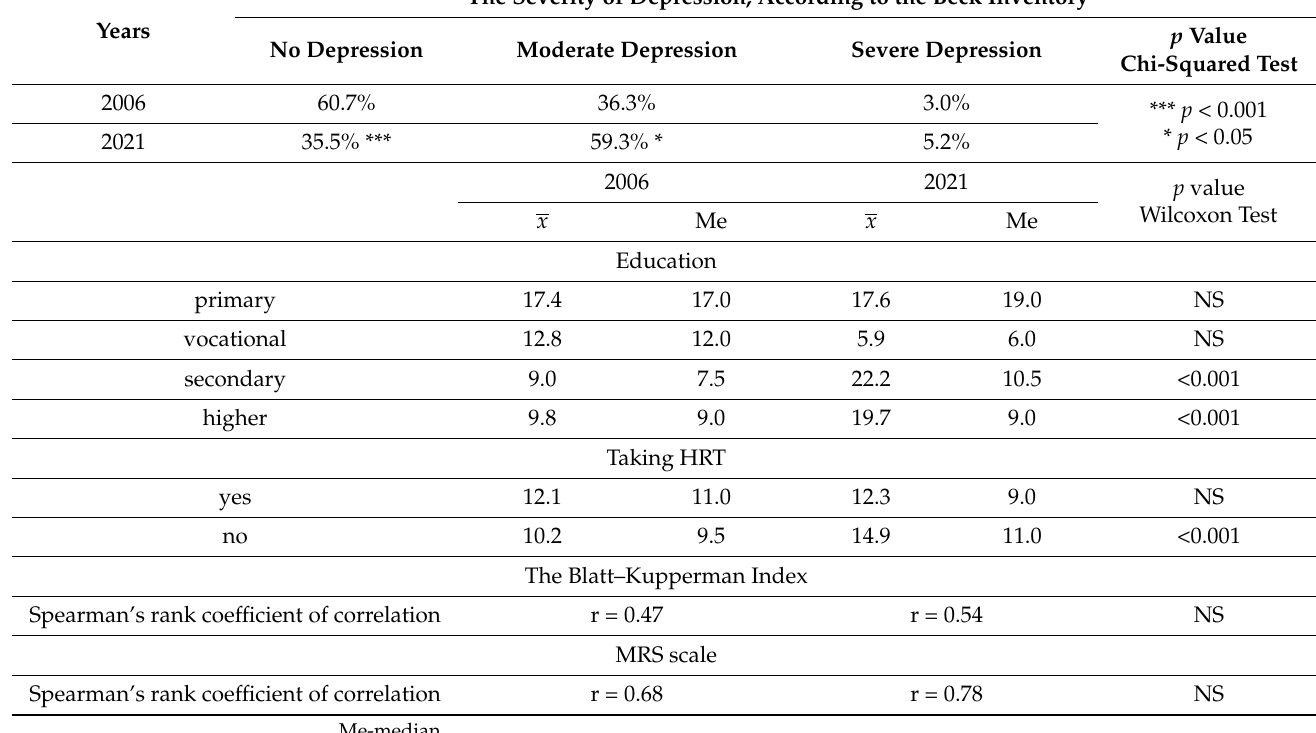
Table 3. The severity of depressive symptoms, according to the Beck scale, in 2006 and 2021.